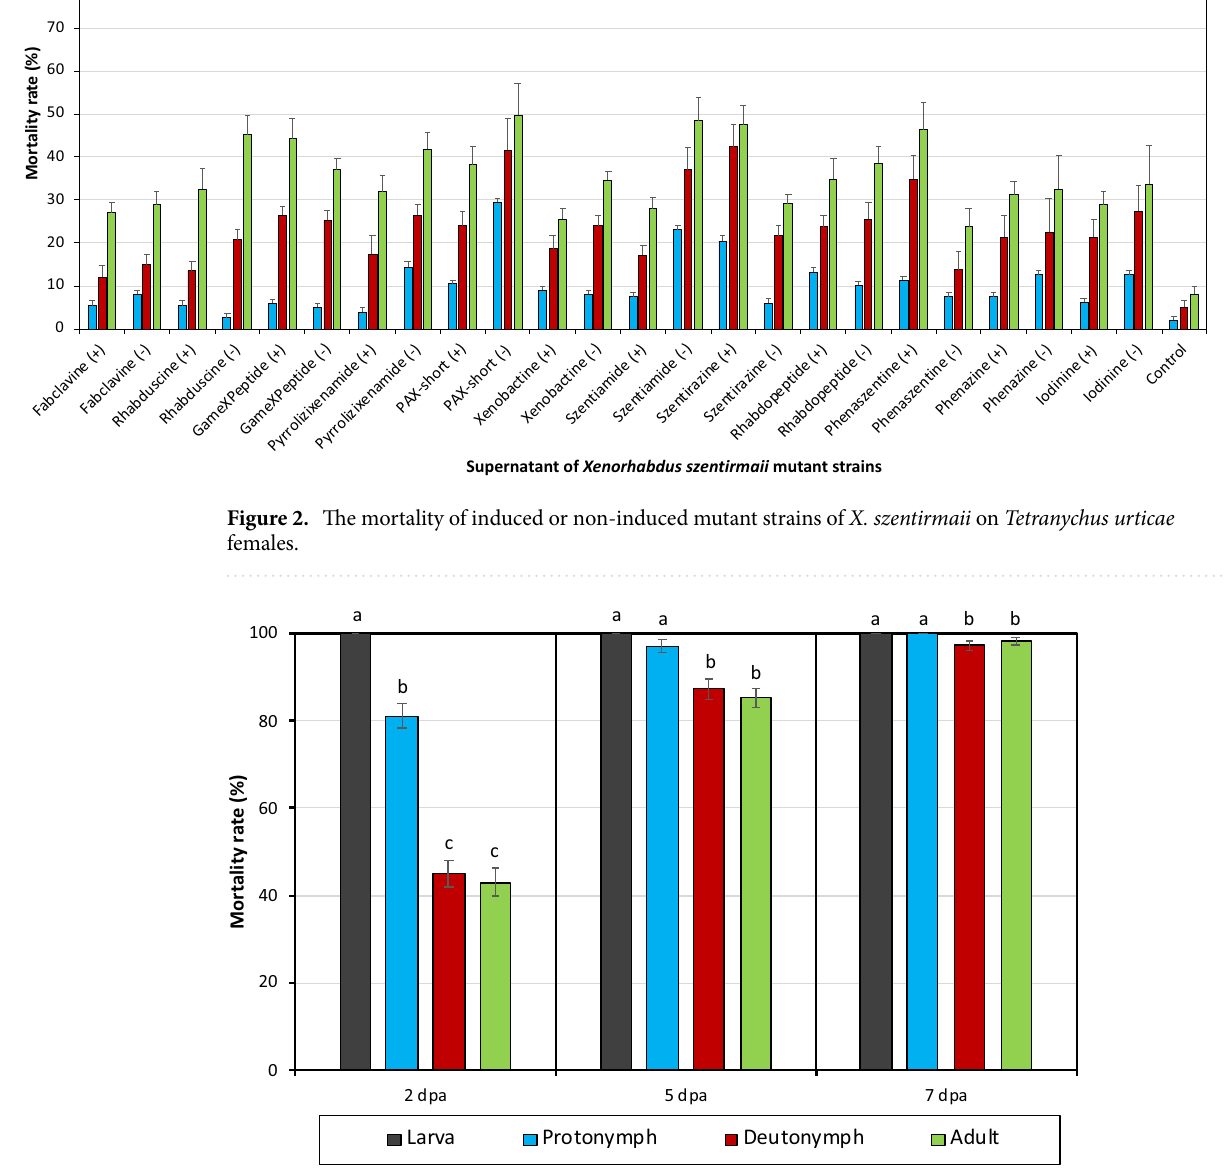
Figure 3. The effects of cell free supernatant produced by induced Xenorhabdus nematophila (pCEP_kan_ XNC1_1711) mutant strain on different biological stages of Tetranychus urticae in Petri